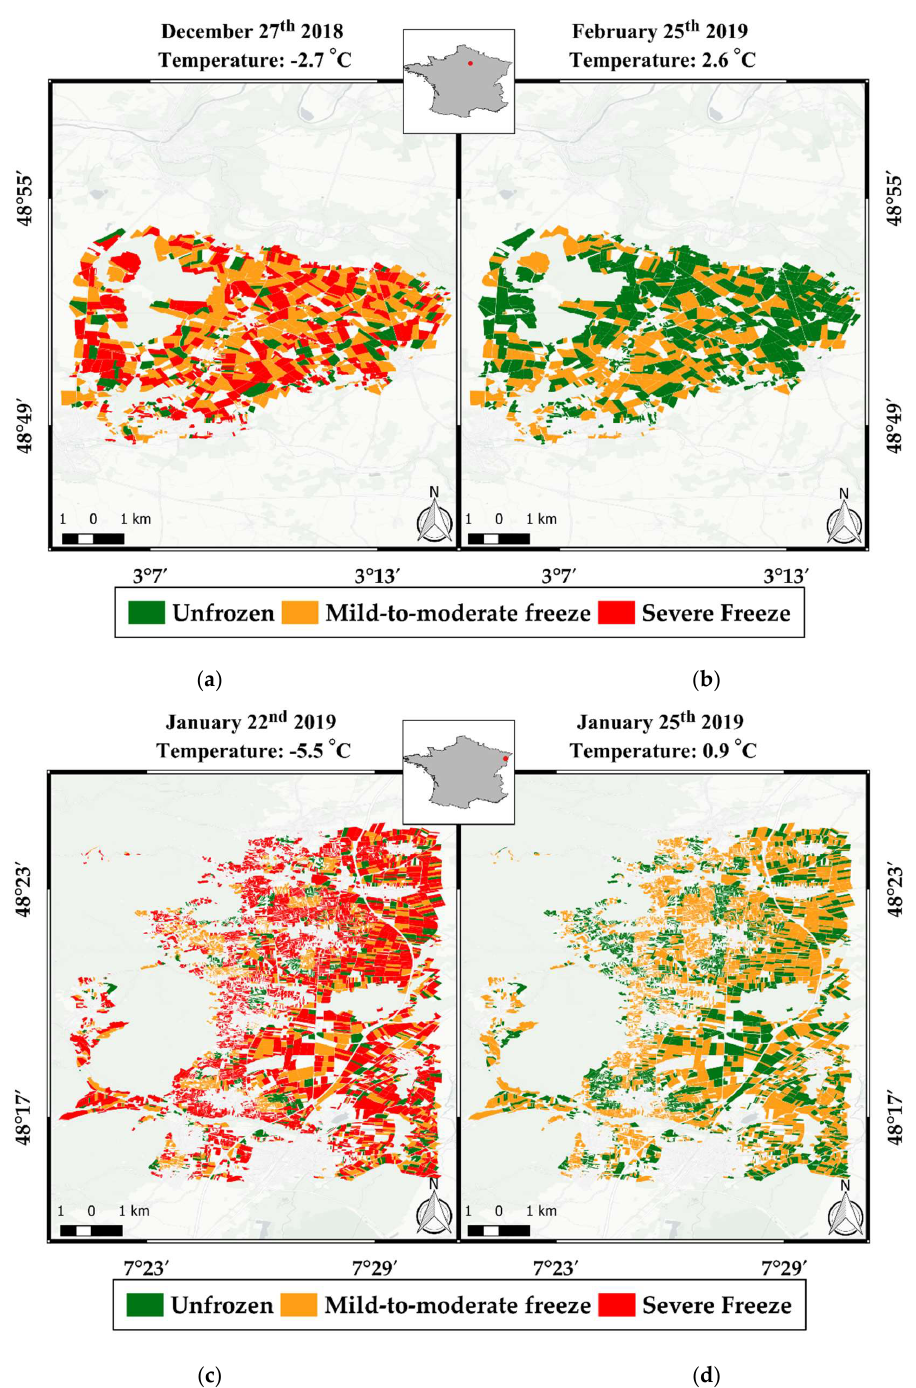
Figure 15. Maps of the frozen/unfrozen plots over site A (a, b) and site B (c, d): ( a ) 27 December